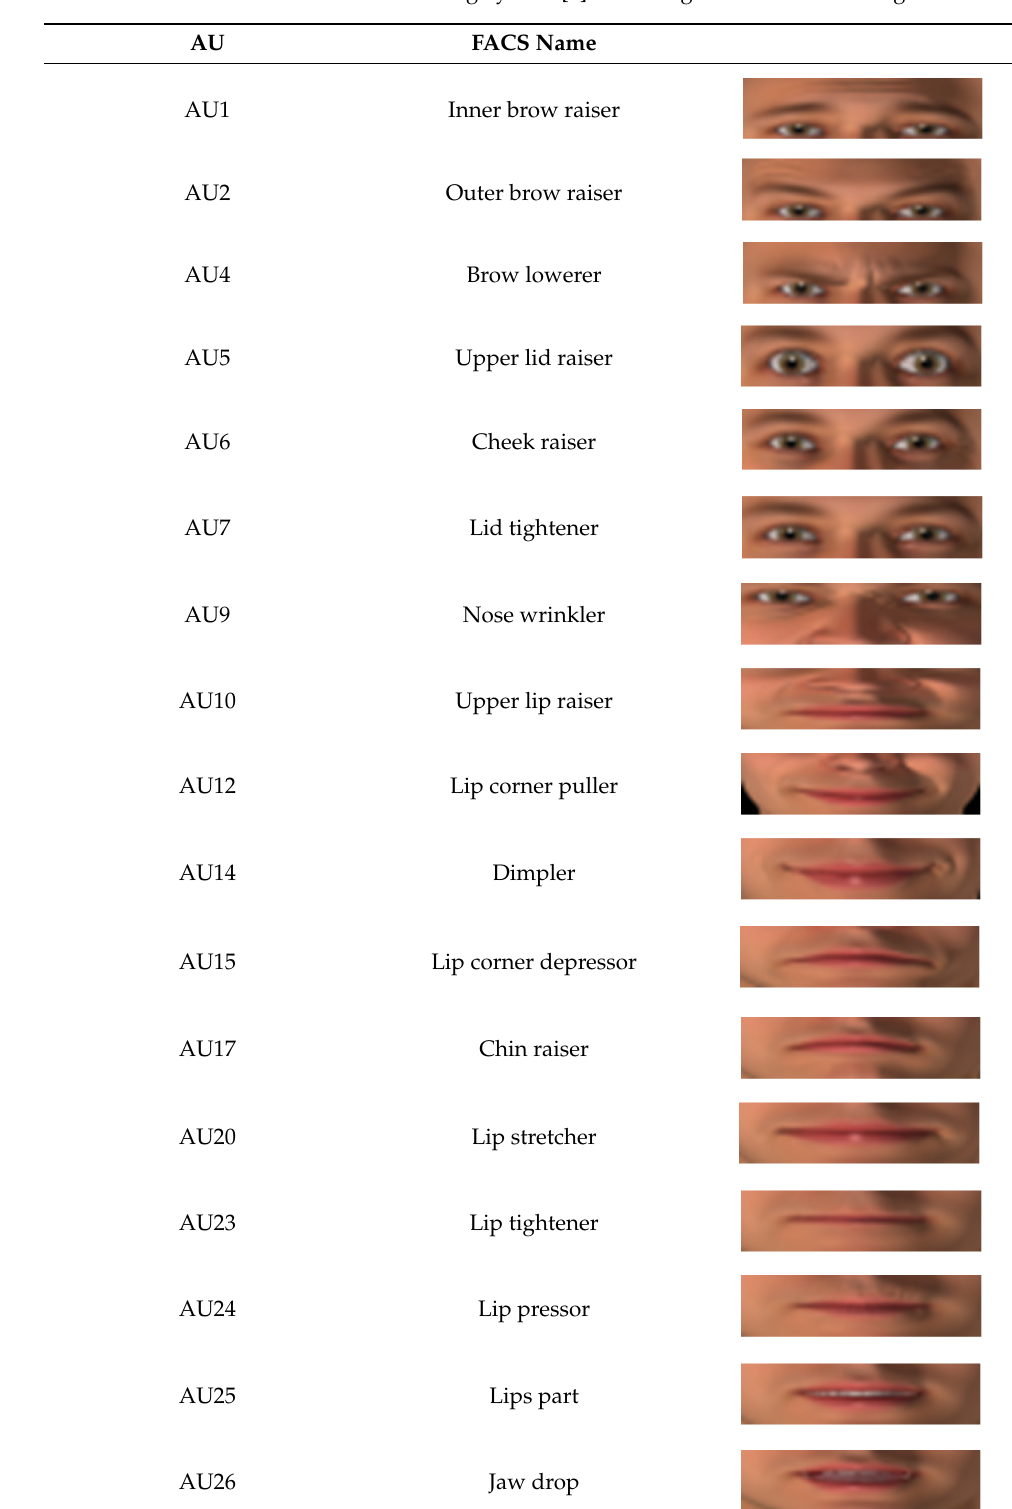
Table 1. AUs from the Facial Action Coding System [2]. The images were created using FACSGen. AU